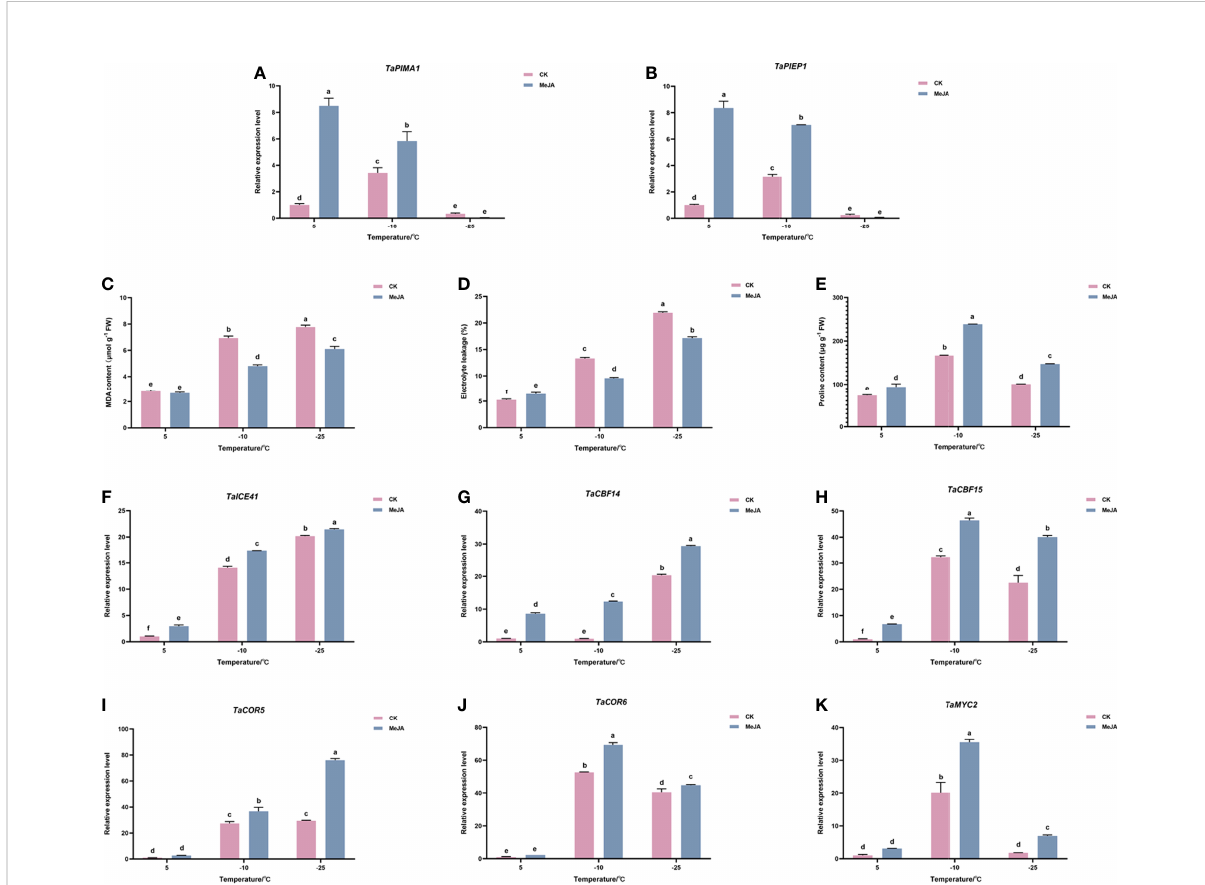
FIGURE 1 Effects of exogenous MeJA on (A) TaPIEP1 expression (B) TaPIMA1 expression (C) electronic leakage, (D) MDA content, (E) proline content, and (F – J) expression of ICE-CBF-COR cold resistance related genes. (K) TaMYC2 expression of Dn1 tillering node under cold stress. The error lines were obtained from three biological replicates. The mean values of the experimental data were analyzed by one-way ANOVA analysis. The comparison method was the least signi fi cant difference (LSD), and the bar graphs with different letters indicated signi fi cant differences ( p <